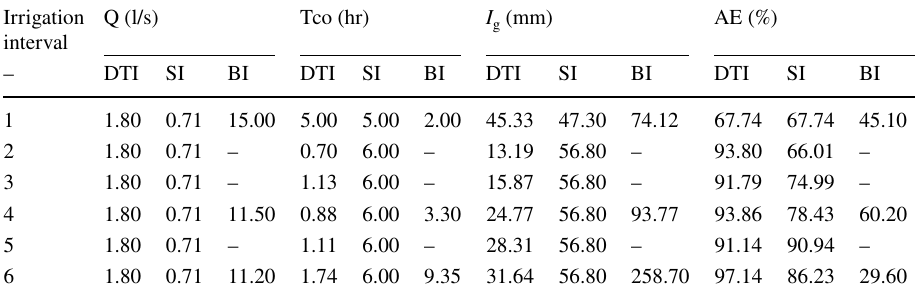
Q, inlet flow; Tco, cut–off time; Ig, gross irrigation requirement; AE,